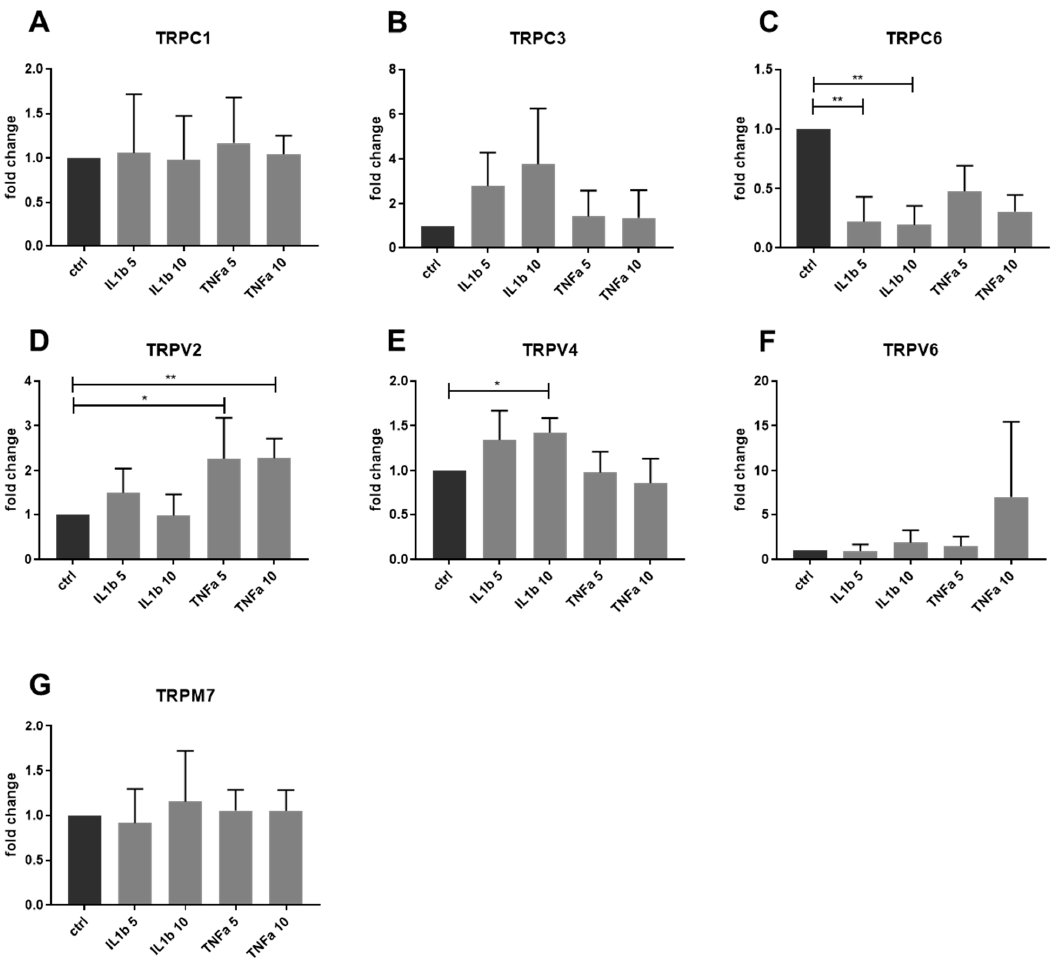
Figure 2. Gene expression of TRP channels in IVD cells treated with 5 and 10 ng/mL IL-1 β or TNF- α . Gene expression of ( A ) TRPC1, ( B ) TRPC3, ( C ) TRPC6, ( D ) TRPV2, ( E ) TRPV4, ( F ) TRPV6, and ( G ) TRPM7. Graphs show 2 − dd C t (mean ± SD, n = 5). Asterisks indicate statistical significance (* p < 0.05, ** p < 0.01, Kruskal–Wallis test and Dunn’s multiple comparison test).